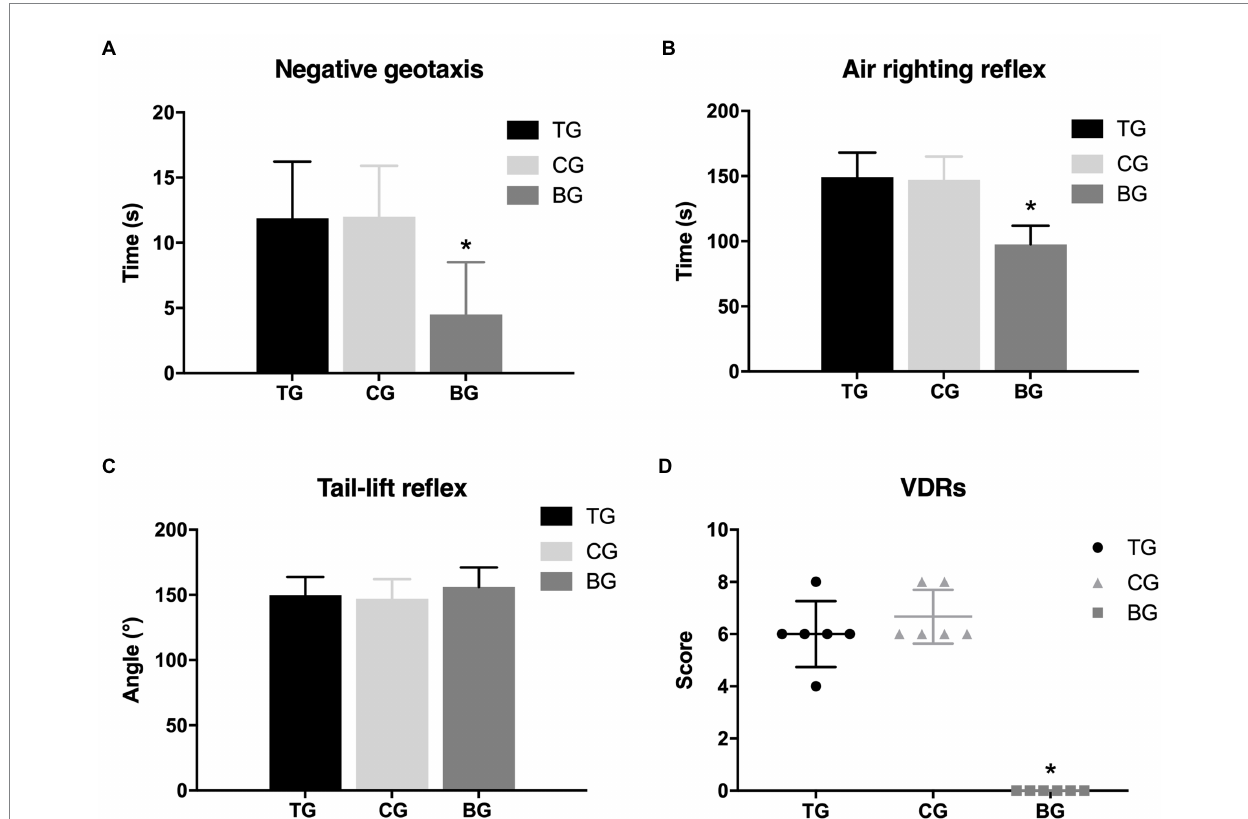
FIGURE 6 Defibrinogenation did not affect vestibular dysfunction. There was no significant difference between TG and CG in the negative geotaxis (A) , air-righting reflex test (B) , and tail-lift reflex (C) , as well as the VDRs (D) . * p <